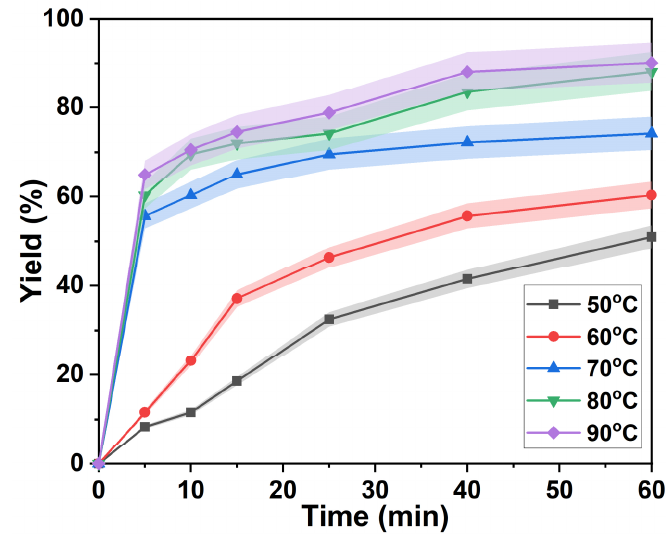
Figure 2. Lignin separation yield at different temperatures.